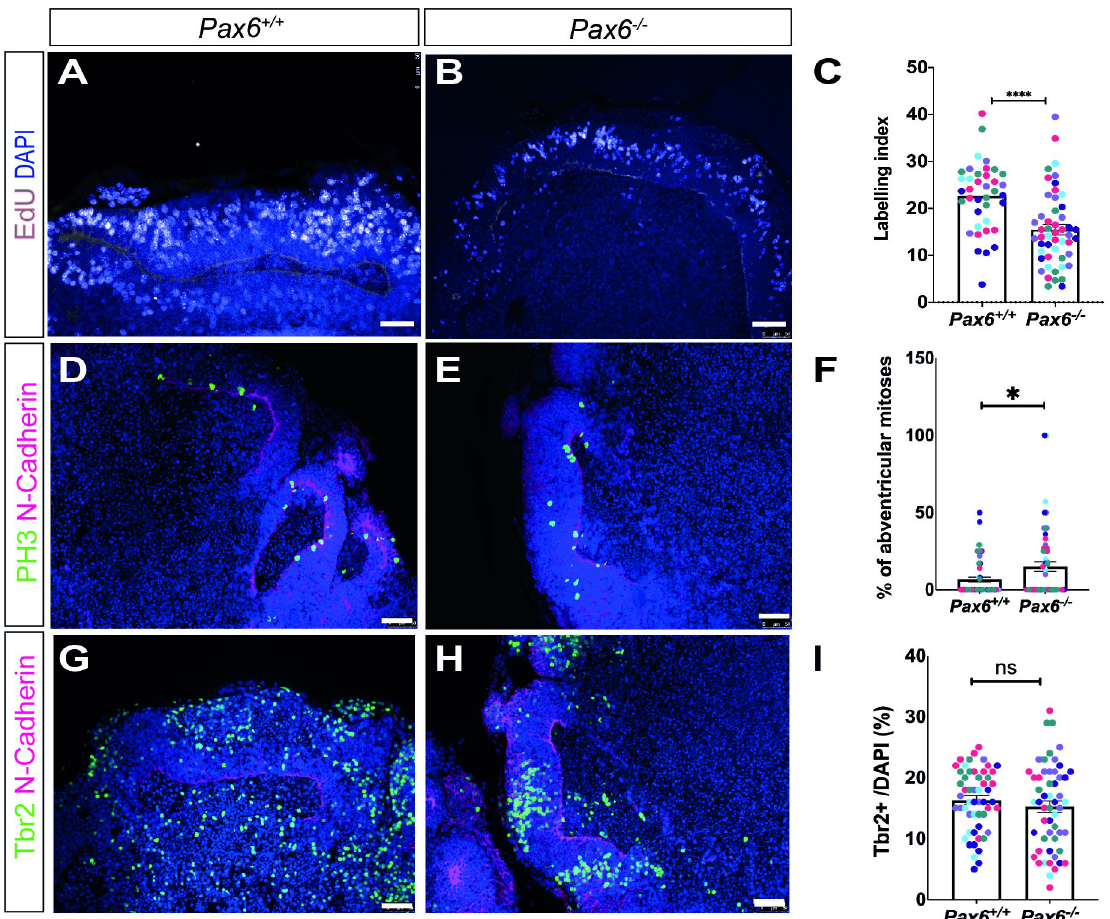
Fig 2. Day 9 Pax6 -/- cerebral organoids display phenotypes similar to mouse Pax6 -/- cerebral cortex. (A,B) Pax6 +/+ and Pax6 -/- organoids pulse labelled with EdU for 2 hours, stained for N-cadherin expression (red) and EdU (pink) (C) Graph showing EdU labelling index in control and Pax6 -/- day 9 organoids. LI is significantly lower in mutants (Student’s t test, p < 0.0001, n = 39–49 organoids from 5 batches). (D,E). Immunostaining for PH3 (green) to identify mitotic cells and N-cadherin (magenta) to show neuroepithelium. (F) Graph showing percentage of mitotic cells (PH3+) located 5 or more cell diameters away from lumenal edge in control and Pax6 -/- day 9 organoids. Mutants show a significant increase in abventricular mitoses (Student’s t test, p = 0.0407, n = 28–43 organoids from 5 batches). (G,H) Immunostaining for Tbr2 (green) and N-cadherin (magenta) (I) Graph showing percentage of Tbr2+ cells in Pax6 -/- and control organoids. Student’s t-test indicated no significant difference between mutants and controls, p = 0.381, n = 53–54 organoids from 5 batches). Graphs in panels C,F and I show mean ± SEM from 39–54 organoids of each genotype, consisting of ~10 organoids from each of 5 independent batches (indicated by spot colour). Scale bar: 50 μ m.